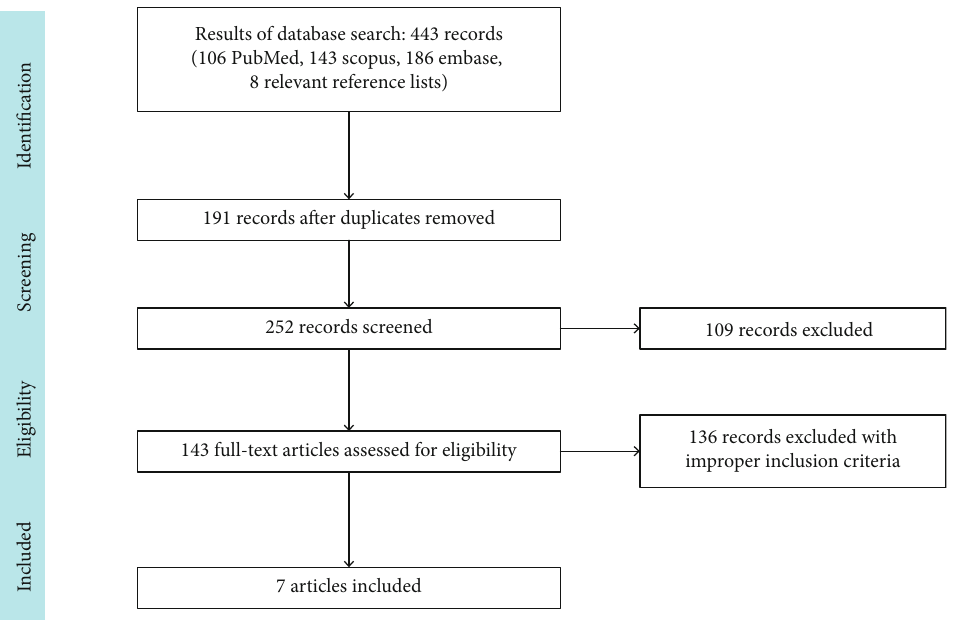
Figure 1: Procedure of the systematic search and